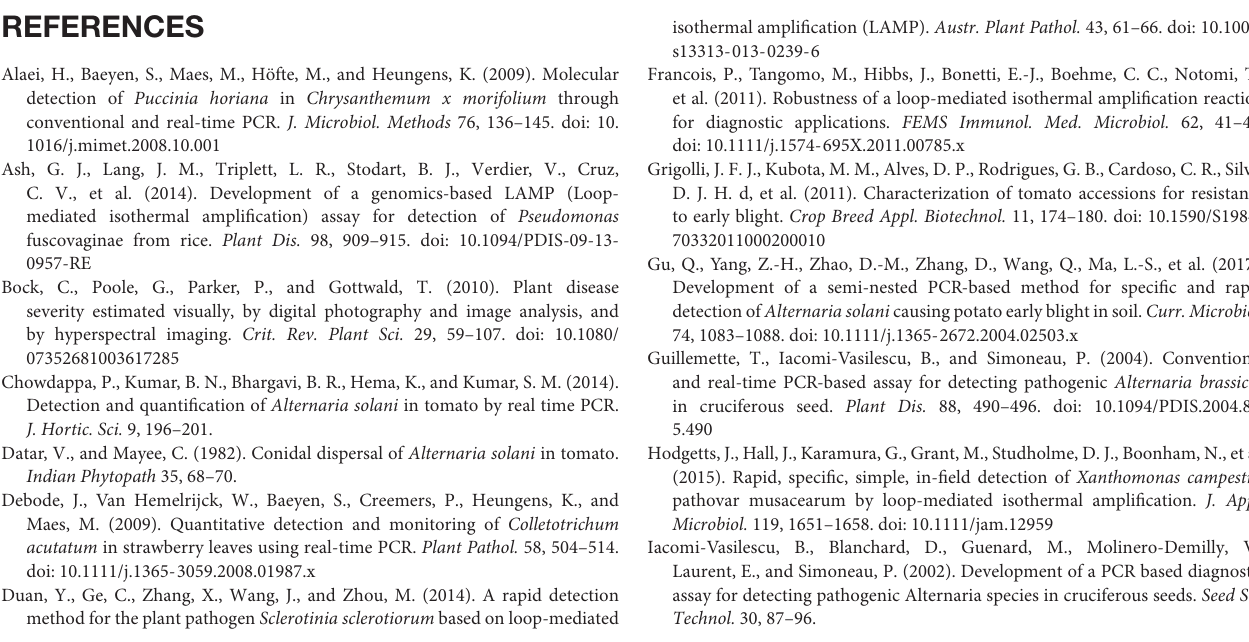
FIGURE S1 | Detection of A. solani using the optimized LAMP system. LAMP assay and visual inspection using a fluorescent metal indicator (calcein) observed by the naked eye. ( A) Positive reactions turned green in the presence of Calcein and negative became brown. (B) The LAMP assay products were evaluated using 2% agarose gel electrophoresis. The ladder-like bands indicate a positive reaction for A. solani . Lane M, DL2000 DNA markers, tube 1 represents a positive reaction; tube 2 represents the negative control. The same results were obtained in three repeat assessments. FIGURE S2 | Specificity of the duplex PCR. Duplex PCR was used using the DNA of both Late blight (497 bp) pathogen and early blight (384 bp) pathogen along with their respective PCR Primer sets. Lane M: DL2000bp Marker; Lane 1: Phytophthora infestans and Alternaria solani ; Lane 2: P. infestans ; Lane 3: Alternaria solani ; Lane 4: Negative control. Similar results were observed in three repeat assessments. FIGURE S3 | Sensitivity of conventional PCR. Sensitivity test of conventional PCR confirmed by 2% agarose gel electrophoresis by 10-fold serial dilution of the target DNA. Lane 1: DL2000-bp DNA Marker; Lane 2: 1.36 × 102 ng µ L − 1 : Lane 3: 1.36 × 101 ng µ L − 1 ; Lane 4: 1.36 ng µ L − 1 ; Lane 5: 1.36 × 10 − 1 ng µ L − 1 ; Lane 6: 1.36 × 10 − 2 ng µ L − 1 ; Lane 7: 1.36 × 10 − 3 ng µ L − 1 ; Lane 8: 1.36 × 10 − 4 ng µ L − 1 ; and Lane 9: negative control. FIGURE S4 | Sensitivity test of Nested PCR. Nested PCR sensitivity was tested using 10-fold serial dilutions of purified target DNA of A. solani . Analysis of Nested PCR products by Agarose gel electrophoresis. Concentrations of template DNA were as follows: Lane1: 1.36 × 102 ng µ L − 1 ; Lane 2: 1.36 × 101 ng µ L − 1 ; Lane 3: 1.36 ng µ L − 1 ; Lane 4: 1.36 × 10 − 1 ng µ L − 1 ; Lane 5: 1.36 × 10 − 2 ng µ L − 1 ; control; and Lane M: DL500-bp DNA marker. Similar results were observed in three repeat assessments. FIGURE S5 | Specificity of Real time-qPCR. 27 Amplification Curve: Specificity of real-time qPCR individual DNA templates, total DNA of A. solani isolates extracted from pure culture collected from different geographic areas, other species ( Alternaria citri , Alternaria raphani , Alternaria longipes , and Alternaria zinniae ), other fungal DNA ( Rhizoctonia solani , Botrytis cinerea , Colletotrichum gloeosporioides , and Sclerotinia sclerotiorum ), total DNA of infected field samples, and healthy plants (negative control) and sterile H2O (blank control). Three technical replicates were used in each DNA